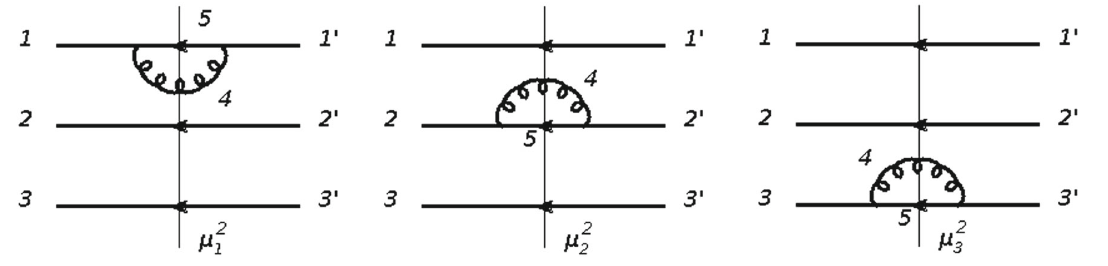
Fig. 1 Self-interaction of effective quarks